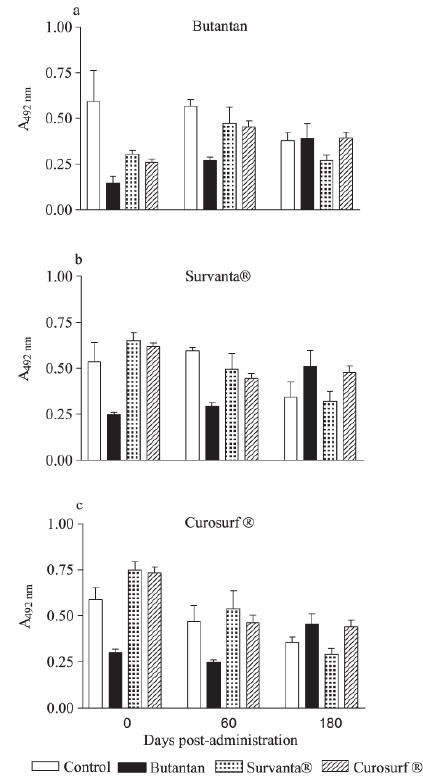
Figure 1 - Antibody levels against (a) Butantan, (b) Survanta, and (c) Curosurf surfactant proteins in the sera of rabbits after intratracheal administration. Bars represent mean absorbance ± SD obtained for a 1:100 dilution of the sera. Data were analyzed by one-way analysis of variance (ANOVA) and Tukey’s multiple comparison test considering P <0.05 (GraphPad Prism, 2.0, 1995).